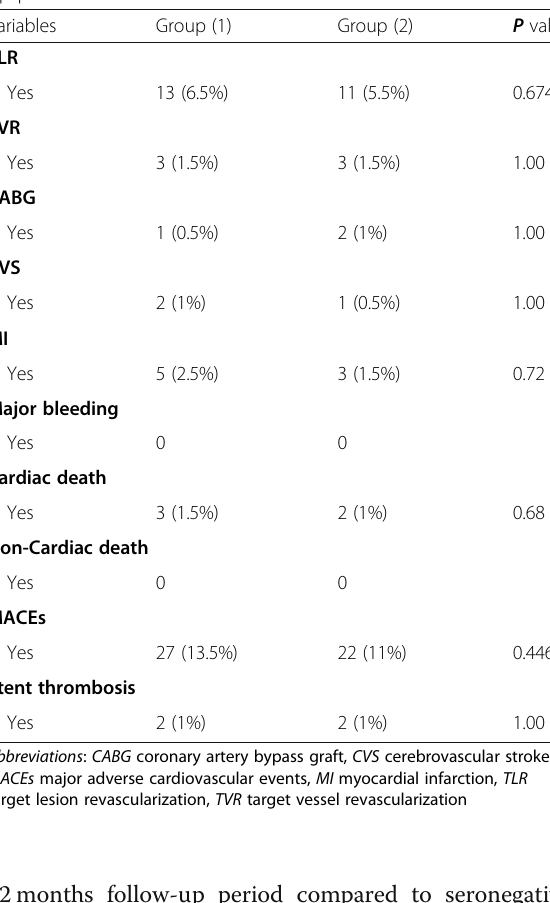
Table 6 Cumulative incidence of MACEs at 12 months follow up